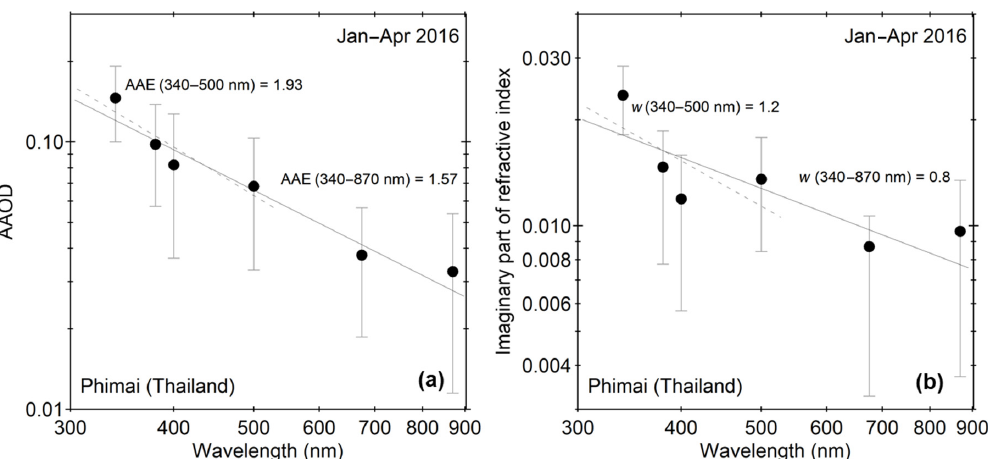
Figure 3. Spectra of (a) AAOD and (b) the imaginary part of refractive index for the period from January to April 2016. The power-law fitting results for 340–870 and 340–500nm are shown by solid and dashed lines, respectively. Error bars represent 1 σ standard deviations for each